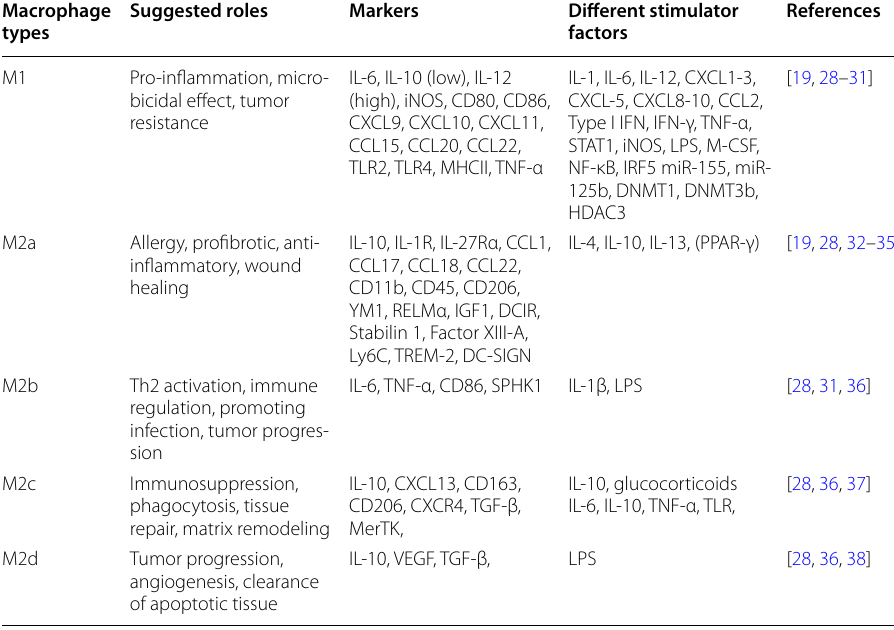
Table 1 Macrophage subtypes and their characteristic markers and